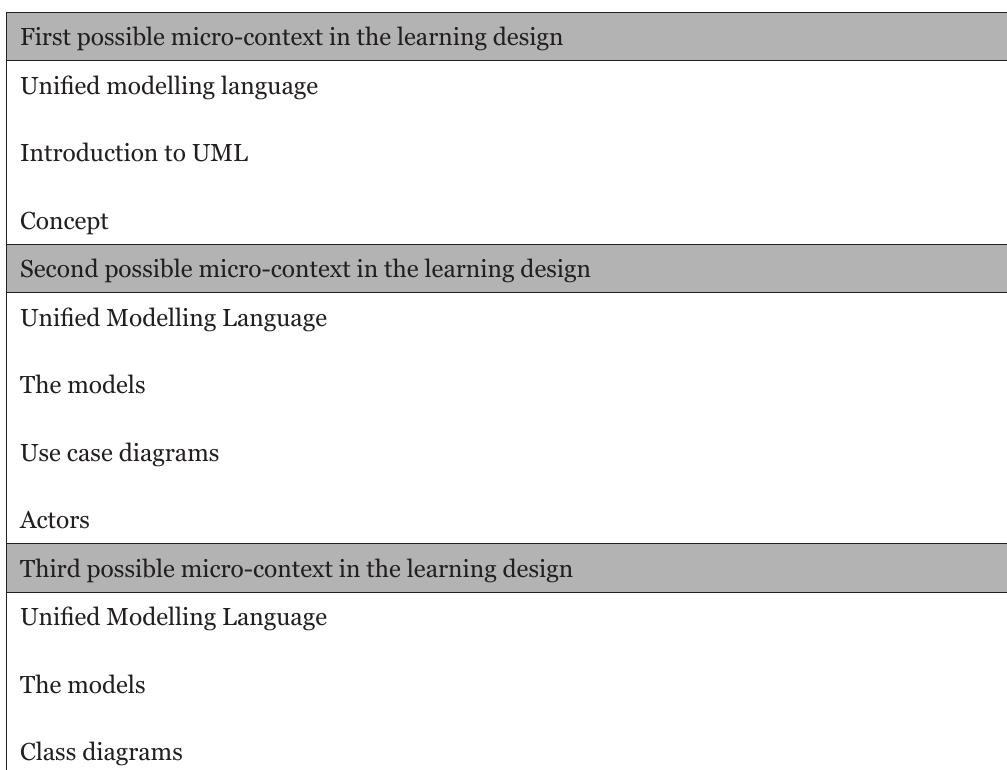
Possible Micro-Context in the UML